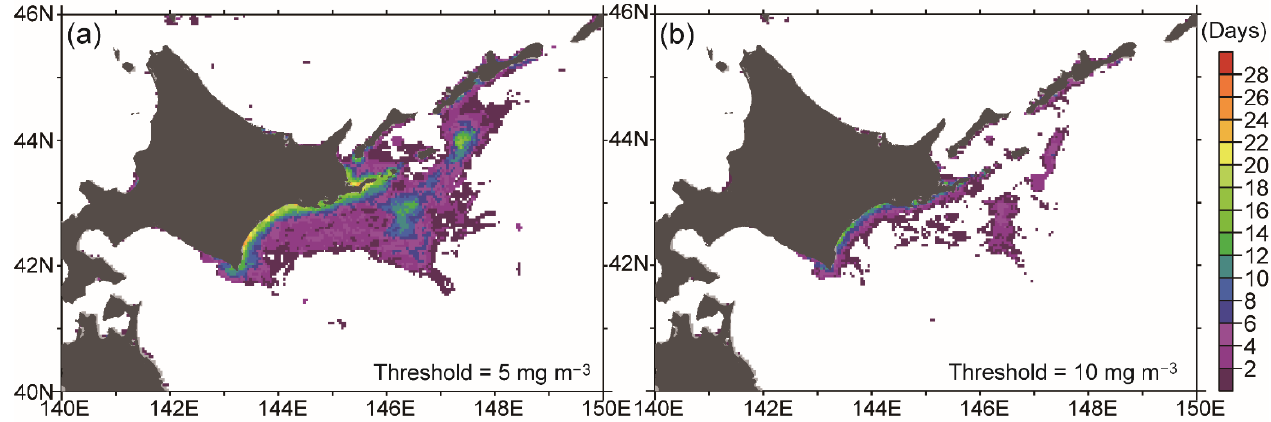
Figure 5. Duration of high SCCs in September 2021 that exceeded ( a ) 5 and ( b ) 10 mg m − 3 . The white area (no-shading) indicates where daily SCCs were lower than the threshold value throughout the month. SCCs were calculated from the near-real-time L4 product.